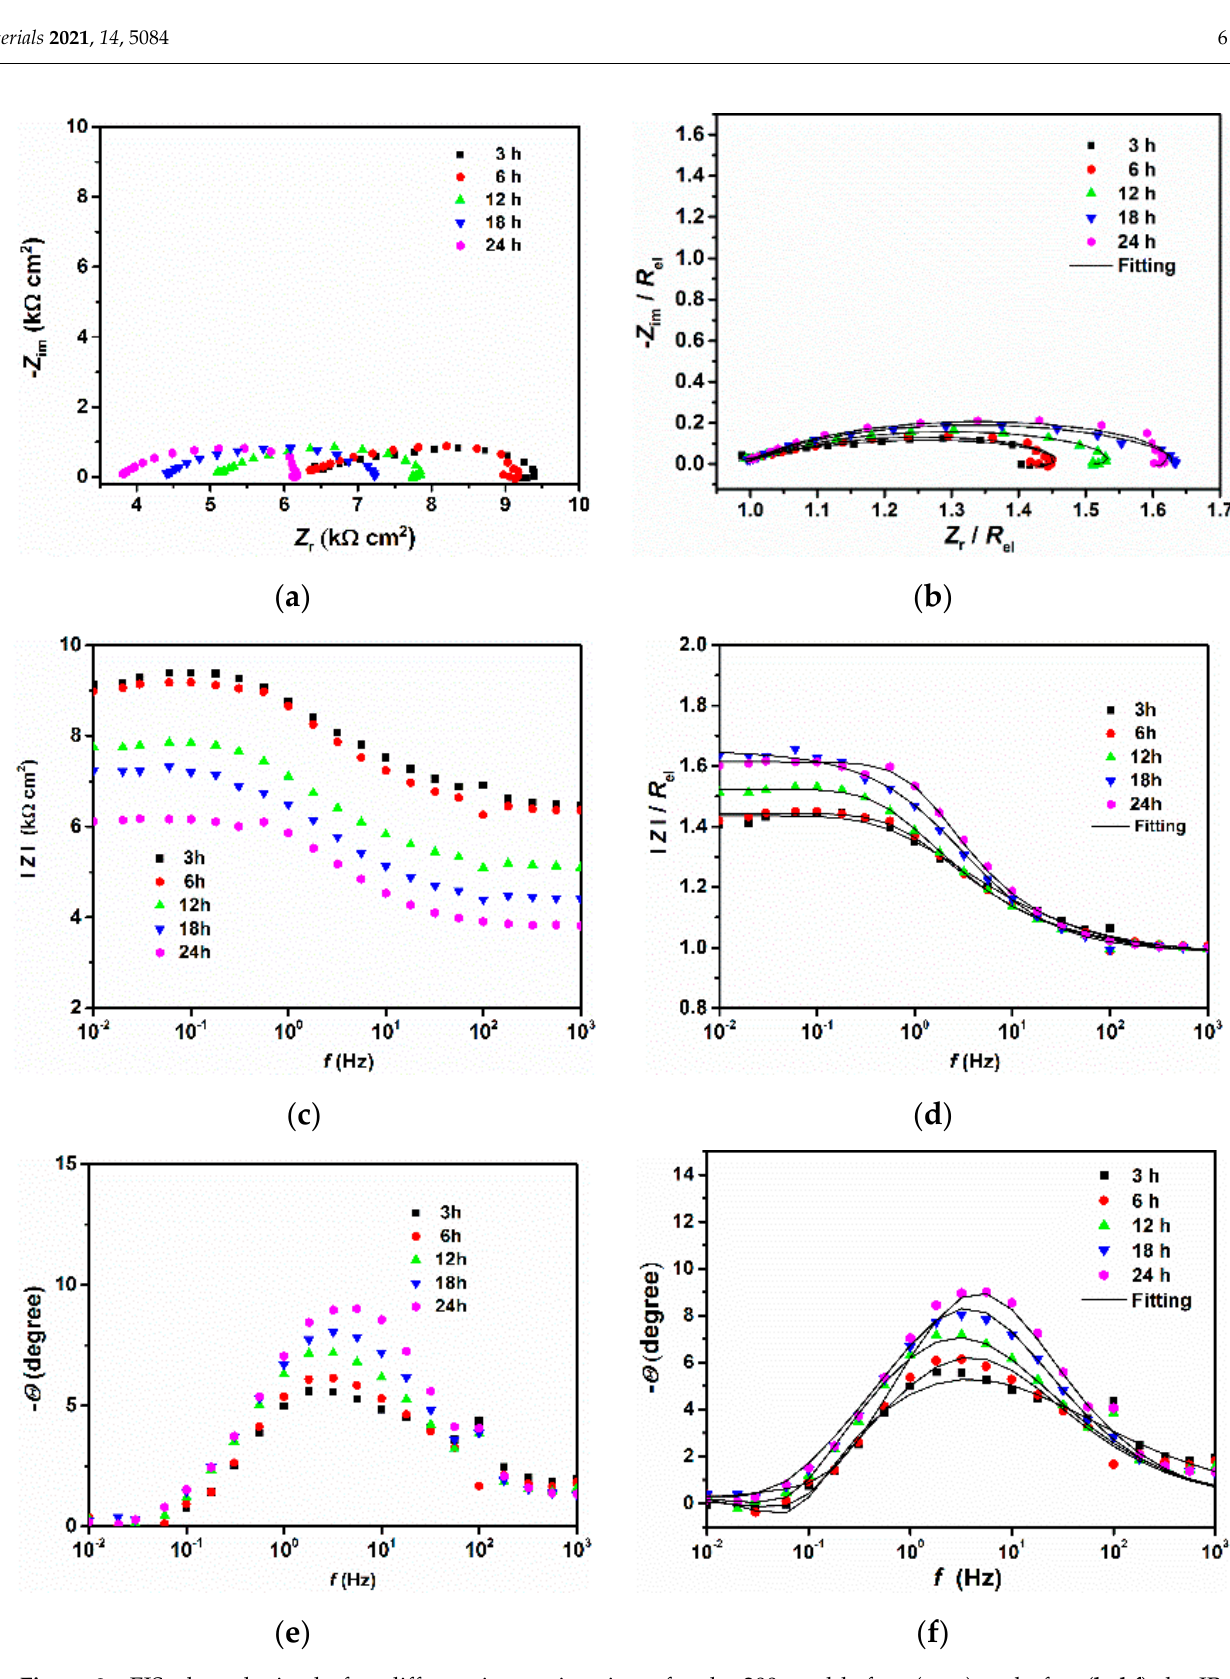
Figure 2. EIS plots obtained after different immersion times for the 200 steel before ( a , c , e ) and after ( b , d , f ) the IR drop correction.